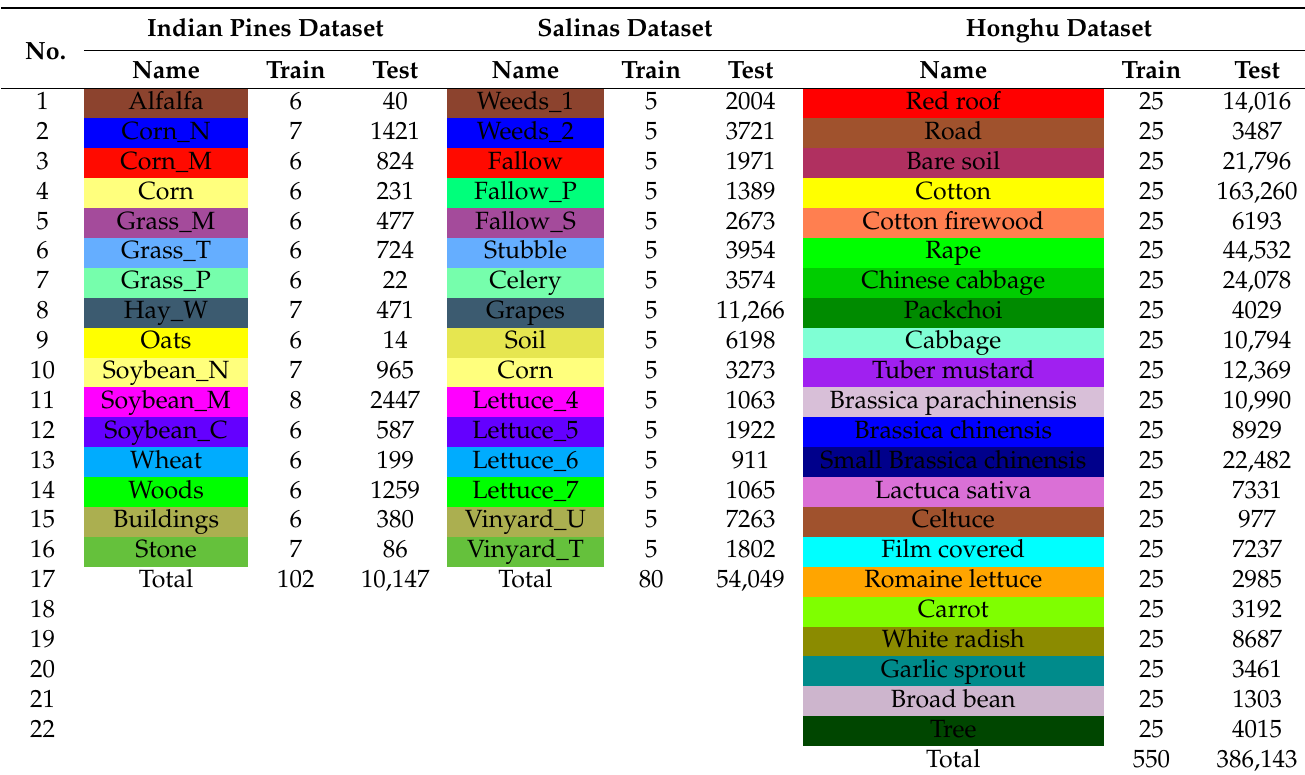
Table 1. The number of training and test set. The colors represent different land covers in the classification